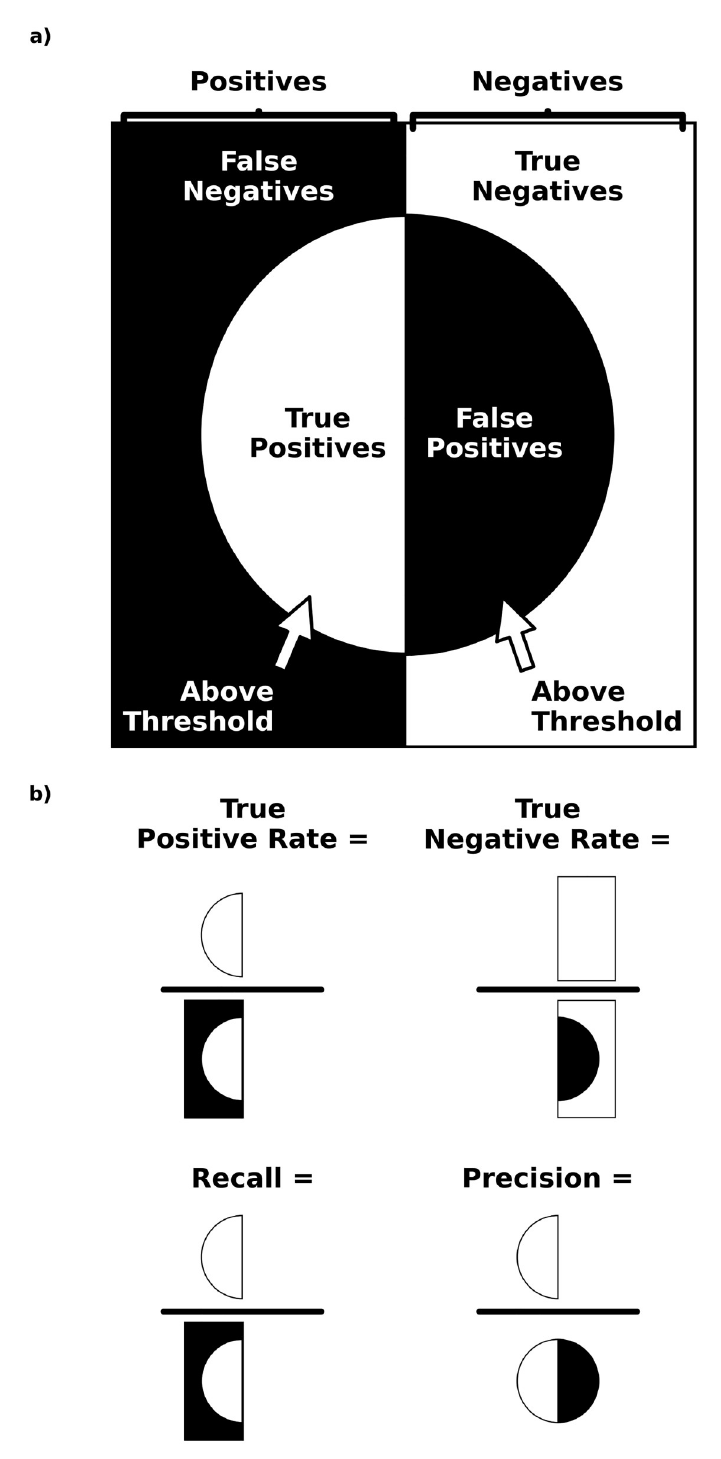
Fig 5. ROCAUC and PRAUC benchmarking. a) Possible prediction outcomes (used for ROCAUC and PRAUC benchmarking) (e.g. true positives) are depicted with black and white wedges. The vertical center line separates all positives and all negatives within the dataset. The center circle contains prediction outcomes for elements above a metric amplitude threshold. b) Rates (e.g. precision and recall) associated with possible prediction outcomes (used for ROCAUC and PRAUC benchmarking) are depicted with wedges and division